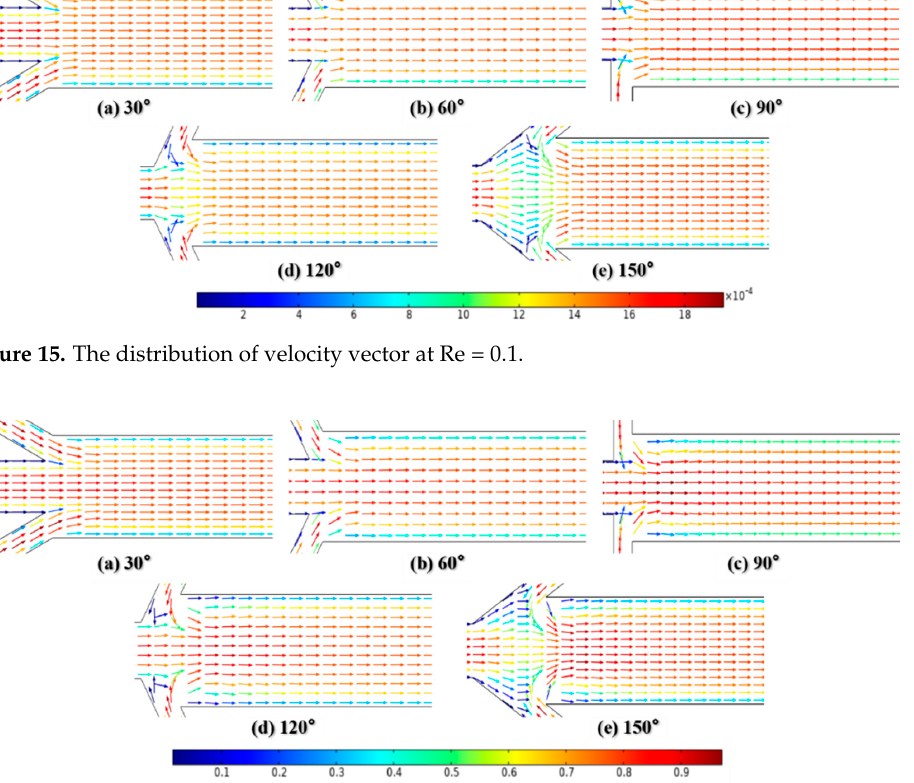
Figure 16. The distribution of velocity vector at Re = 50.